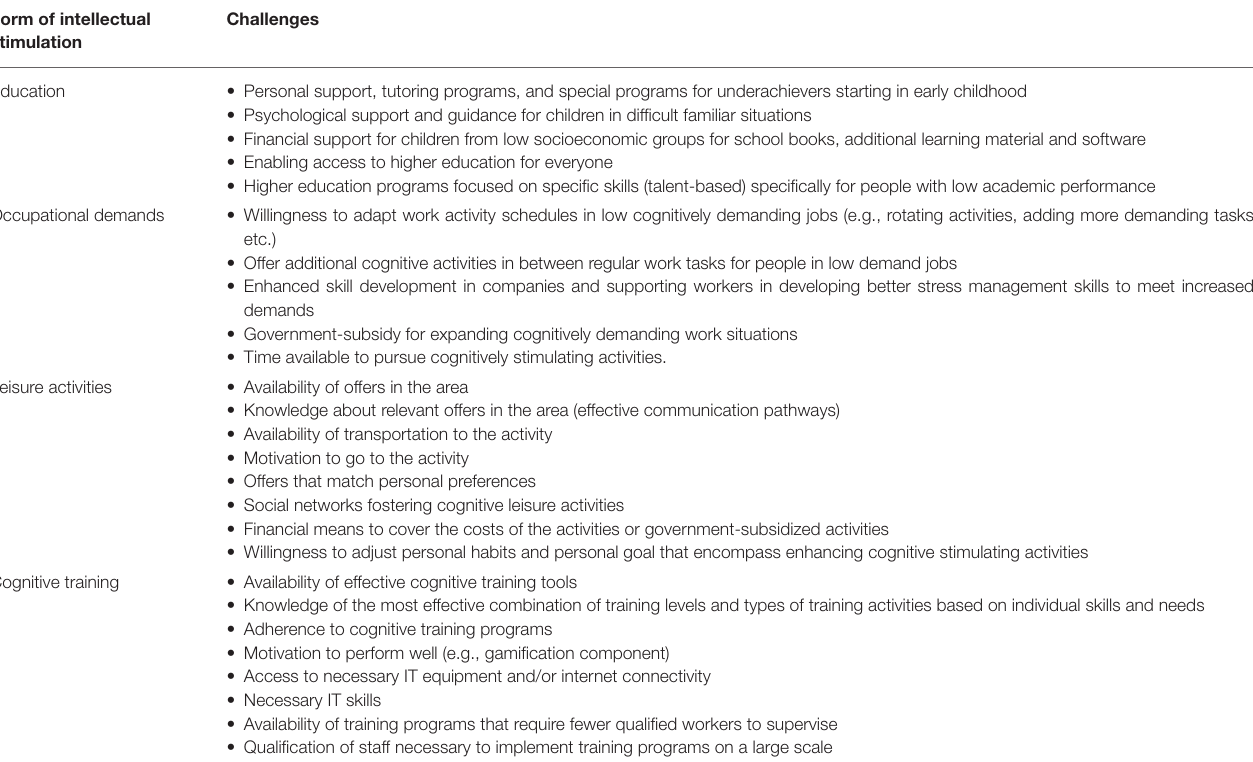
TABLE 1 | Some important challenges for implementing intellectual stimulation within prevention